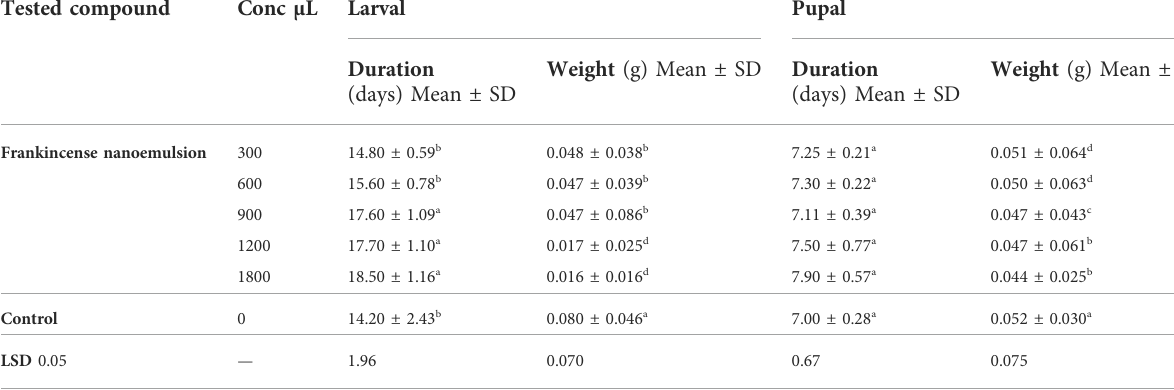
TABLE 3 Latent effects of frankincense nanoemulsion on immature stages of E. insulana . Tested